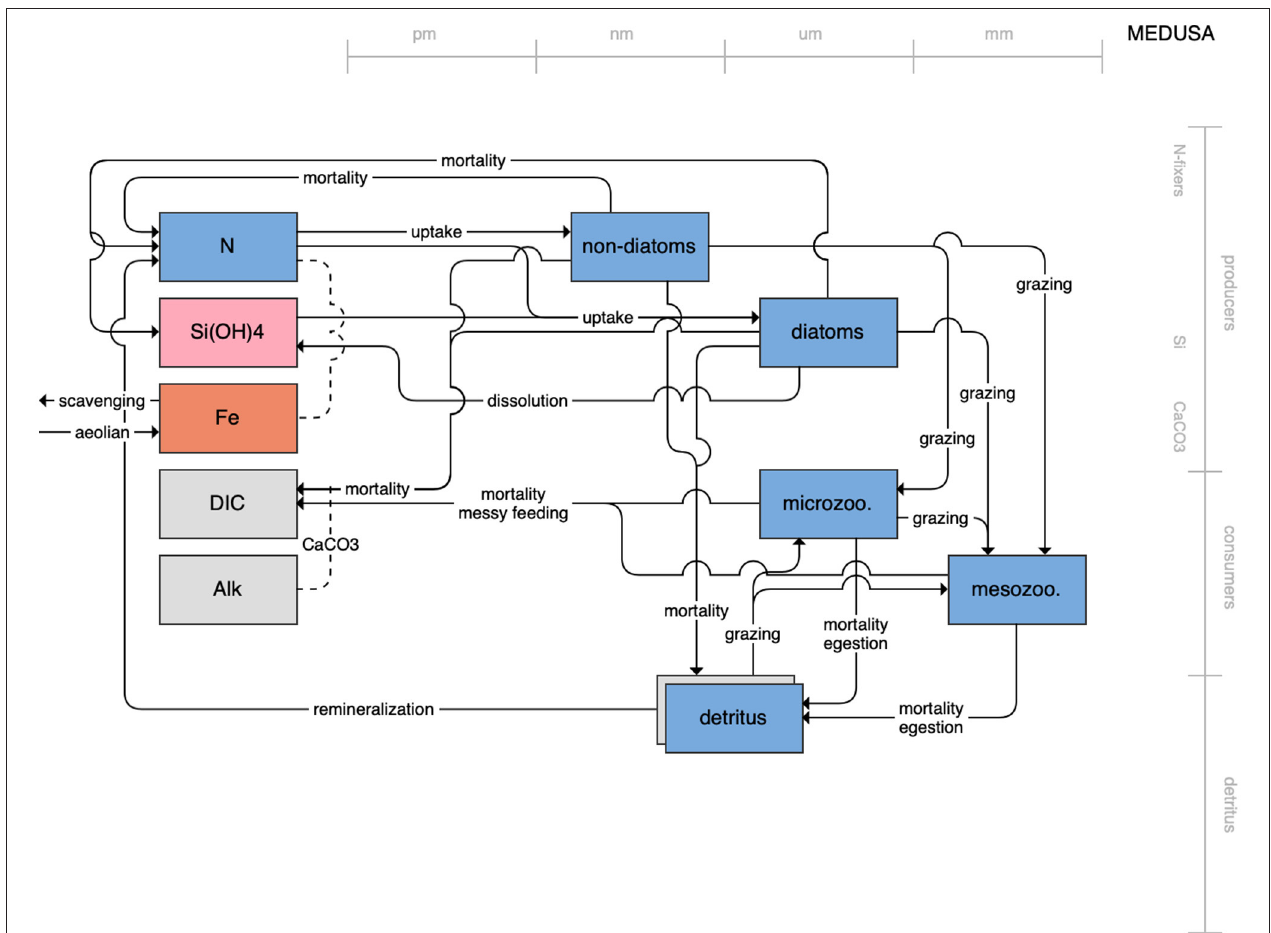
FIGURE 11 | Schematic for the MEDUSA model. See Figure 1 caption for